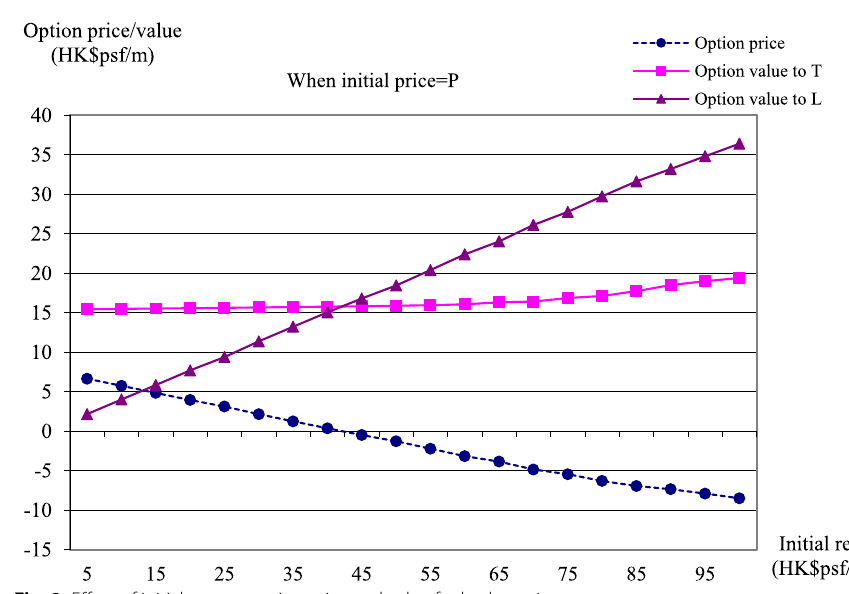
Fig. 9 Effect of initial rent on option price and value for both